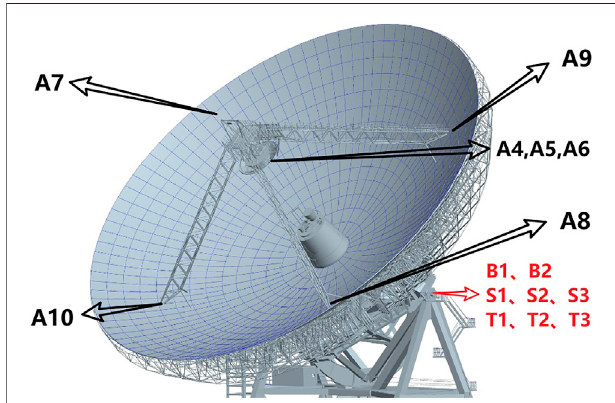
FIGURE 1 | Figure shows the model diagram of the TMRT. The black text “ A ” marks the vibration sensor position, the red “ B ” marks the range sensor position, the red “ S ” marks the stress sensor position, the red “ T ” marks the temperature sensor position. And the numbers are their numbers, such as “ A1 ” means vibration sensor number